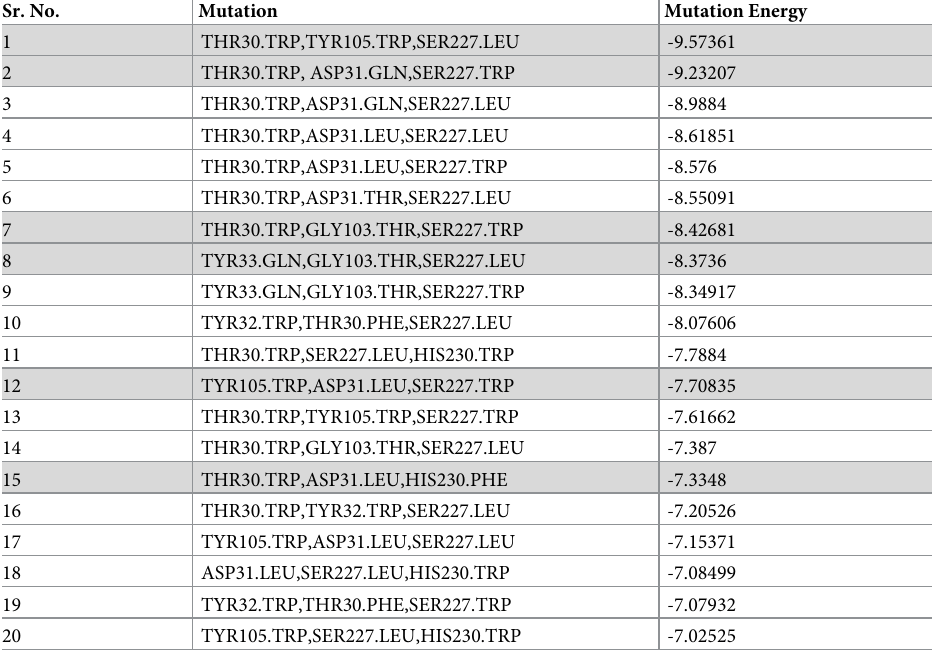
Table 3. Best stabilizing triple mutation combination for scFv with their mutation energy. Sr.